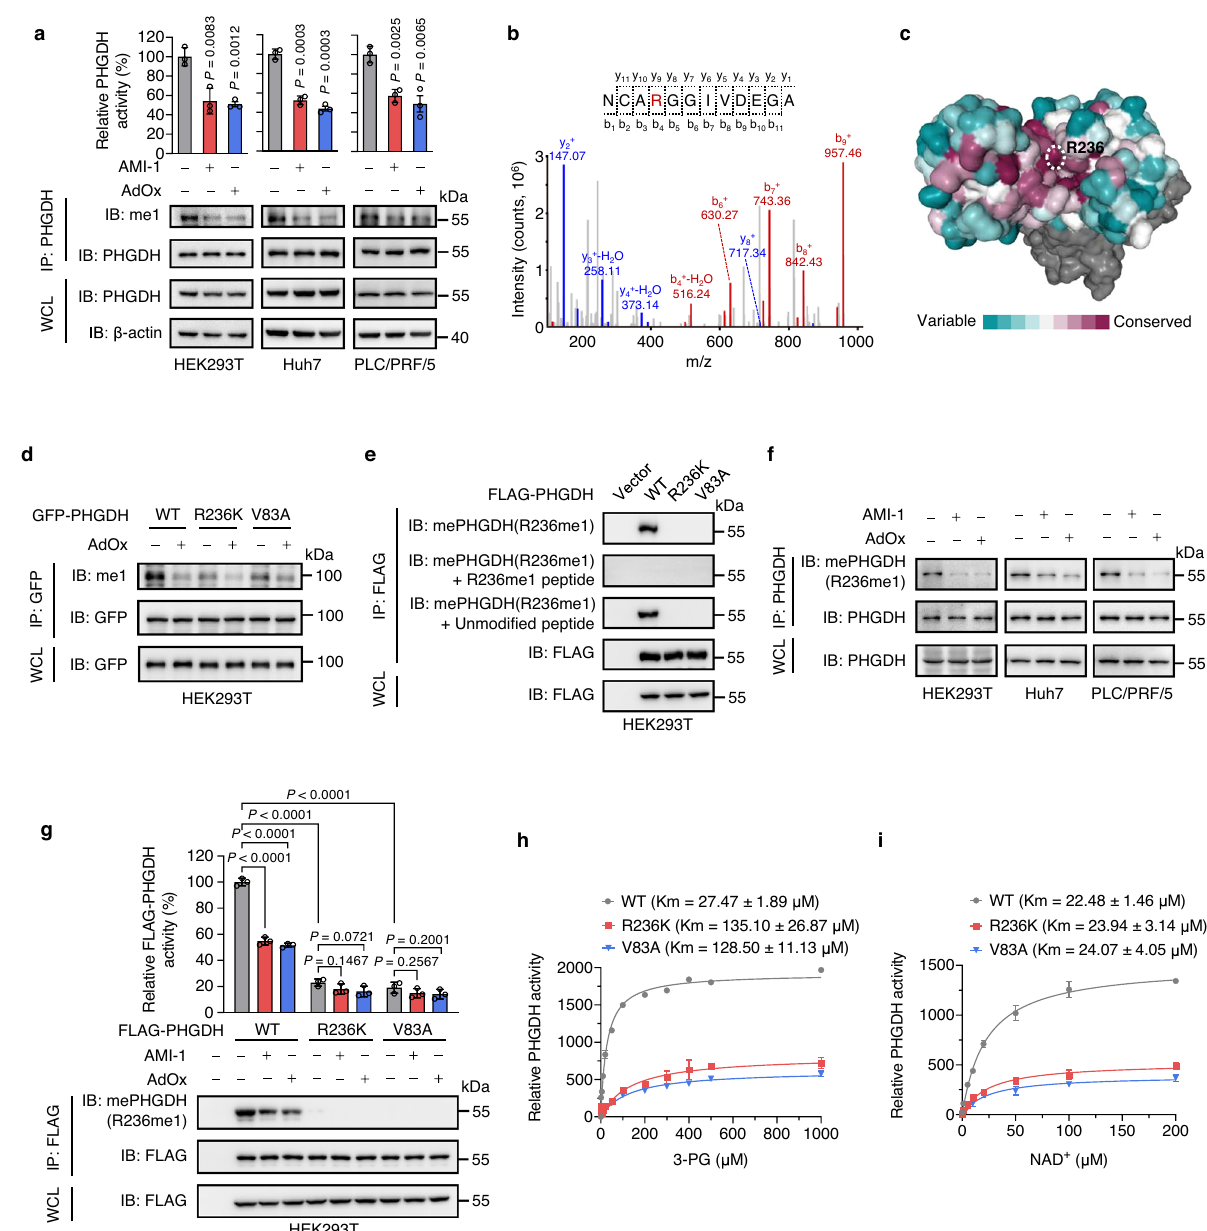
Fig. 2 | Arginine methylation at R236 elevates PHGDH catalytic activity by increasing substrate af fi nity. a Endogenous PHGDH was immunoprecipitated in cells treated with AMI-1 or AdOx for 24h. The mono-methylation (me1) level of PHGDH was determined by immunoblotting. PHGDH activity was measured and normalized to PHGDH protein. Data are presented as the mean±SD ( n = 3 inde- pendent experiments). Statistical analysis was performed using the two-tailed Student ’ s t -test. b MS identi fi cation of R236 mono-methylation of FLAG-PHGDH immunopuri fi edby FLAGbeads. c Sequenceconservation of PHGDHprotein using theConsurfcoloringscheme.Maroonandcyanindicatehighandlowconservation, respectively. d HEK293T cells expressing GFP-PHGDH WT, R236K or V83A were treated with AdOx for 24h. The mono-methylation (me1) level of immunoprecipi- tatedGFP-PHGDHwasdeterminedbyimmunoblotting. e FLAG-PHGDHWT,R236K or V83A was expressed in HEK293T cells. The mono-methylation of immunopur- i fi edFLAG-PHGDHwasmeasuredusingasite-speci fi cantibodyagainstR236mono- methylation (mePHGDH (R236me1)), which was pre-incubated with the R236